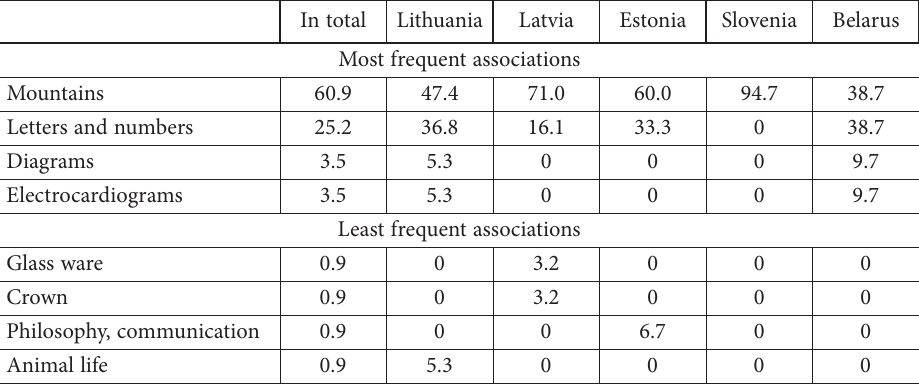
Table 7. Associations of Fragment 4 (%) (source: created by authors) In total